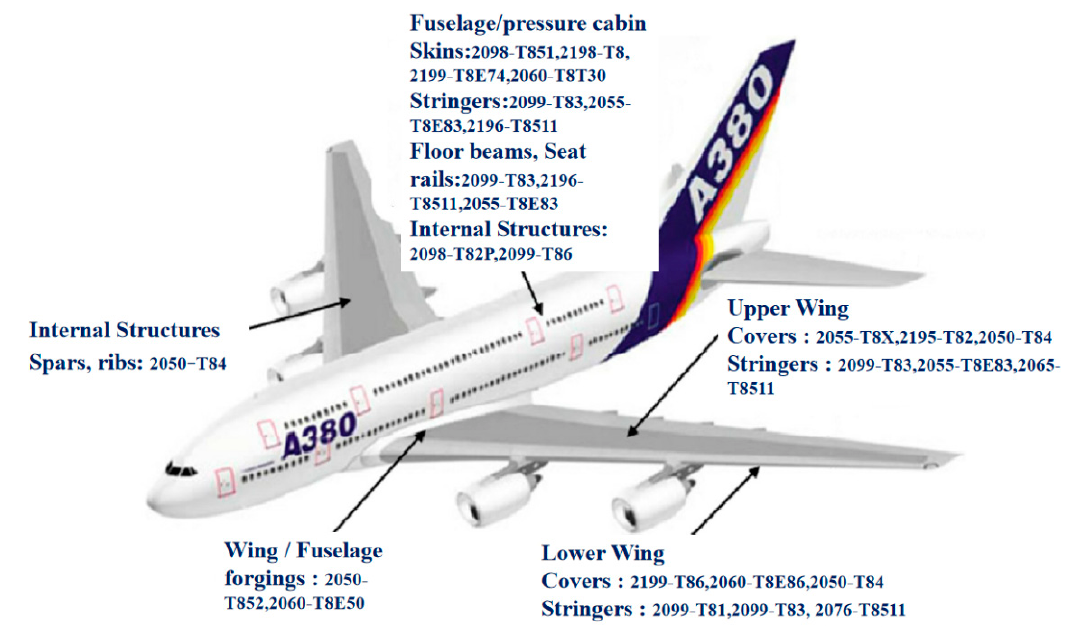
Figure 2. Typical uses of aluminum alloys in an A380 aircraft [15].